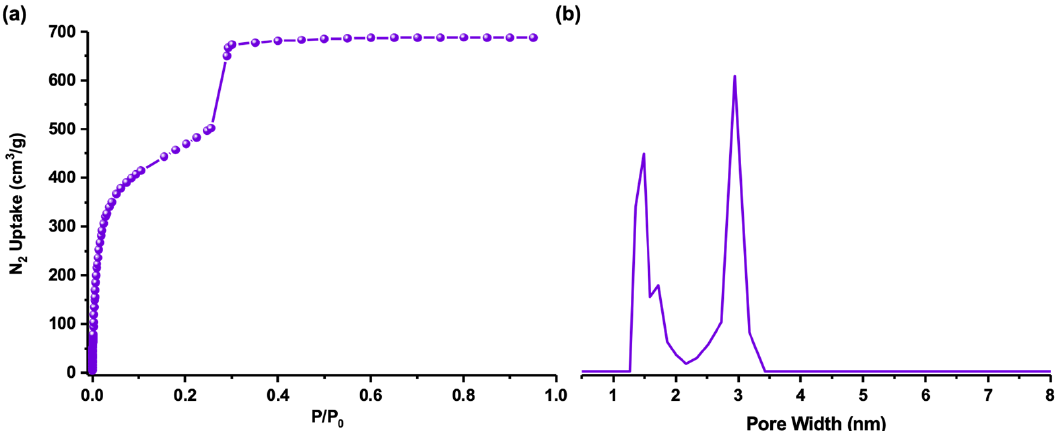
Figure 4. N 2 adsorption isotherm at 77 K ( a ) and pore size distribution of csq-MOF-1 ( b ).